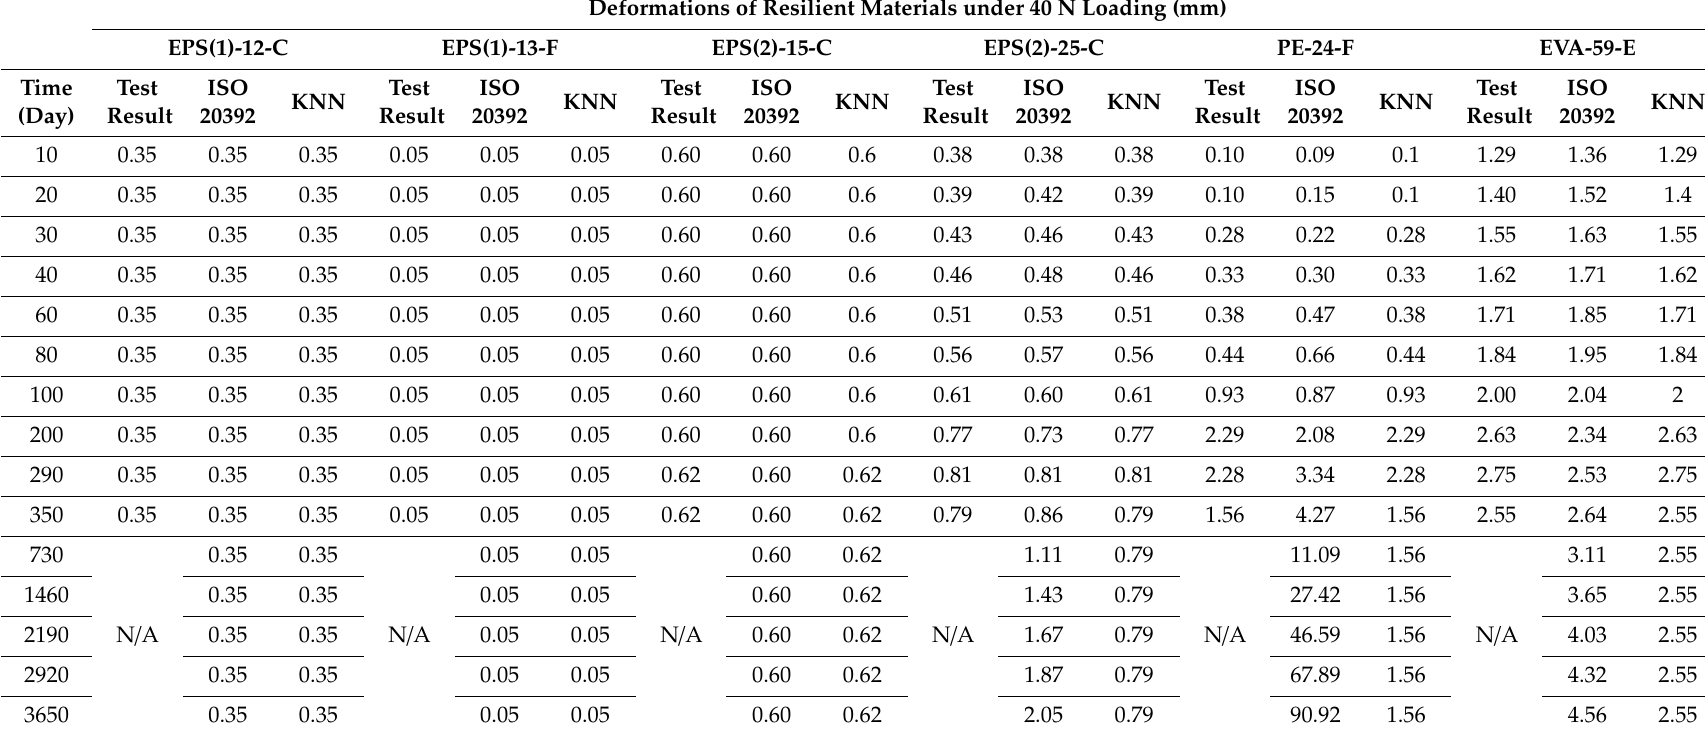
Table A1. Deformations of resilient materials under 40 N